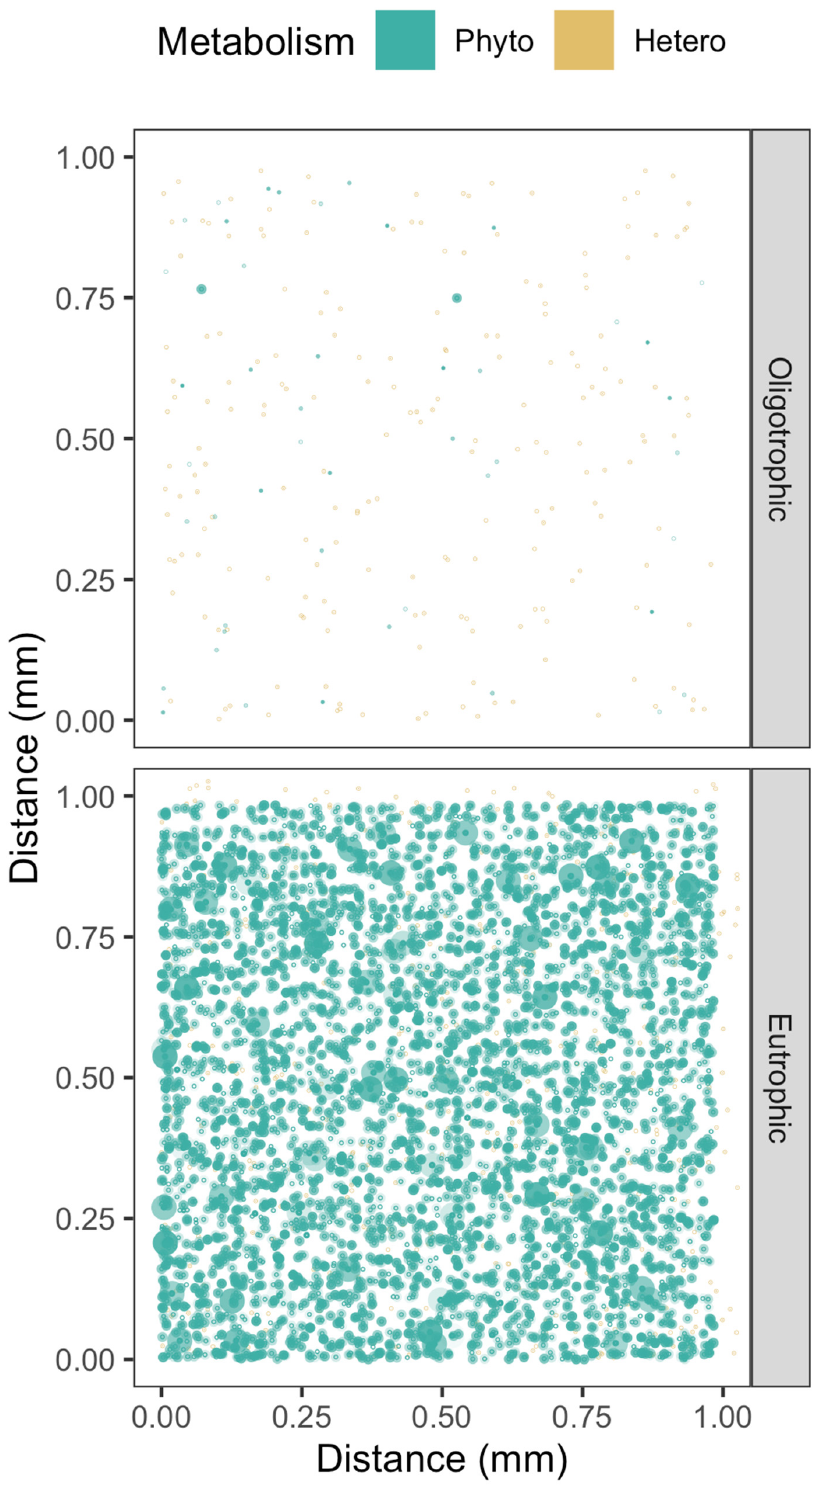
Figure 3. Simulations of [H 2 O 2 ] above seawater [H 2 O 2 ] (pale blue) out from Phytoplankton cells (green spheres, spanning a size range), or [H 2 O 2 ] below seawater [H 2 O 2 ] out from Bacterioplankton cells (red spheres, single nominal cell size). Cell position along a third Z axis is simulated by the ‘alpha’ with lighter cells further back.